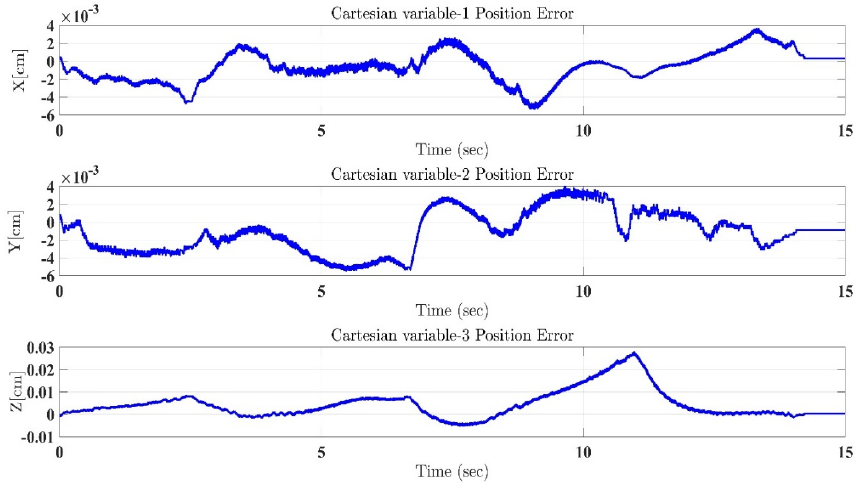
Figure 5. Tracking errors in Cartesian coordinates (X-Y-Z axes) under the proposed controller.